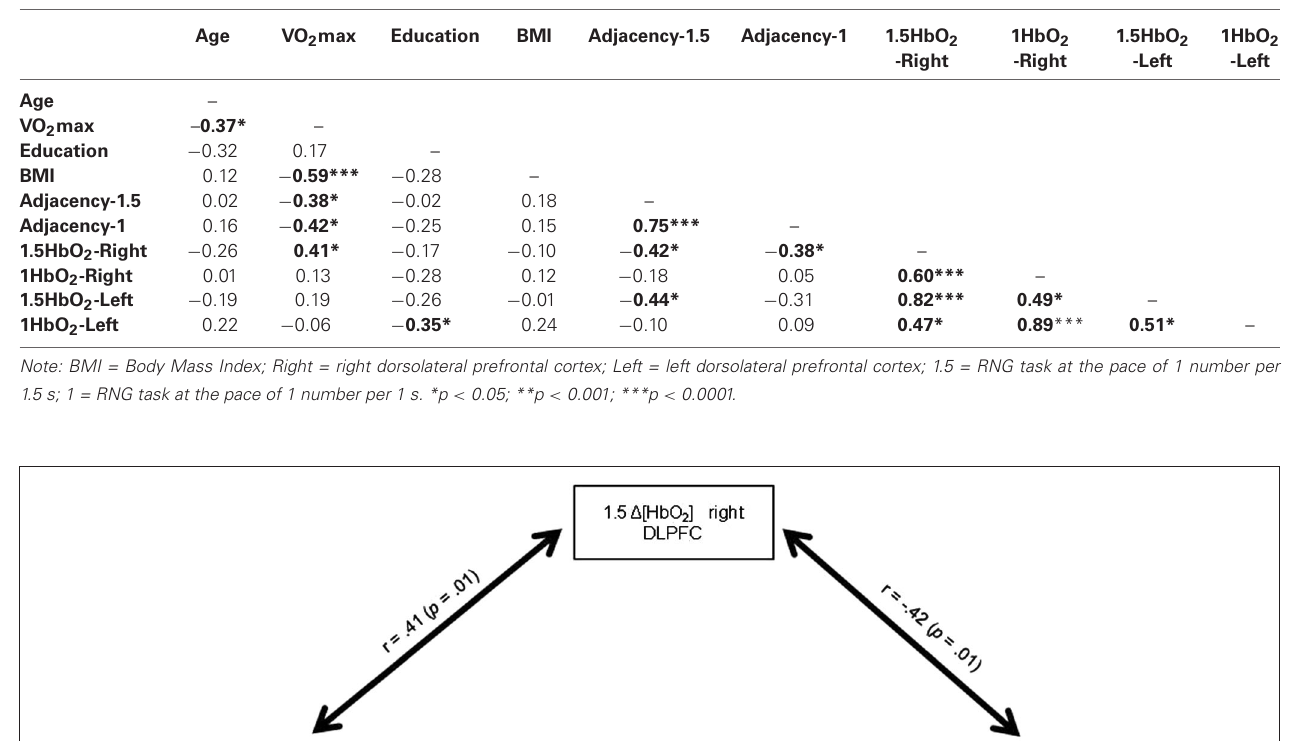
Table 4 | Correlation matrix between the measures of executive performance, the hemodynamic data and the characteristics of the participants . Age